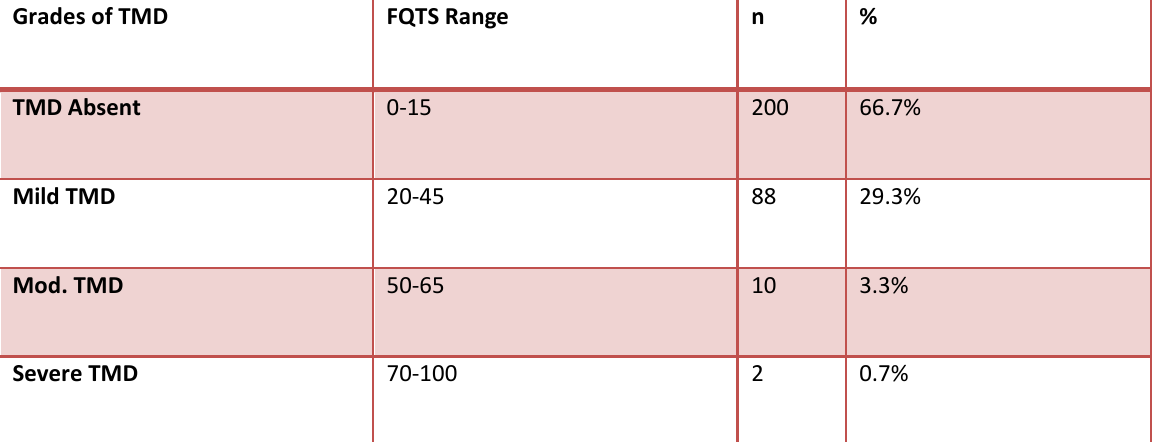
Table 3- Distribution of varying grades of TMD among study participants based on Fonseca